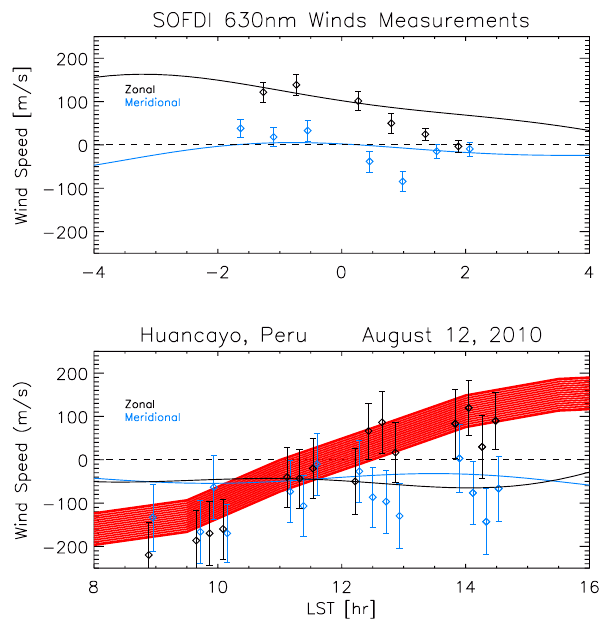
Fig. 4. Top: nighttime OI 630-nm thermospheric winds, repre- sented by diamond points with 1-sigma uncertainty bars, obtained by SOFDI in Huancayo, Peru from the night of 11 August to 12 August 2010. The thin lines are from the HWM07 empirical model. Black data points/lines represent the zonal wind (positive values are eastward) while light blue data points/lines represent the meridional wind (positive values are northward). Bottom: daytime OI 630-nm thermospheric winds as measured from one field-of-view by SOFDI on 12 August 2010, presented in the same manner. The red bar rep- resents the 1-sigma range of geophysical variability of climatologi- cal CHAMP winds during equinox at low Kp and low F10.7 values (Liu et al., 2006).